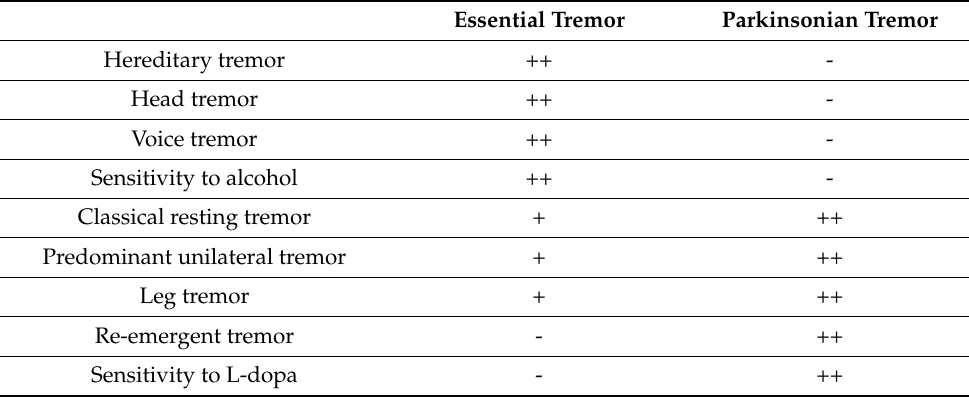
Table 1. Clinical criteria to separate essential and Parkinsonian